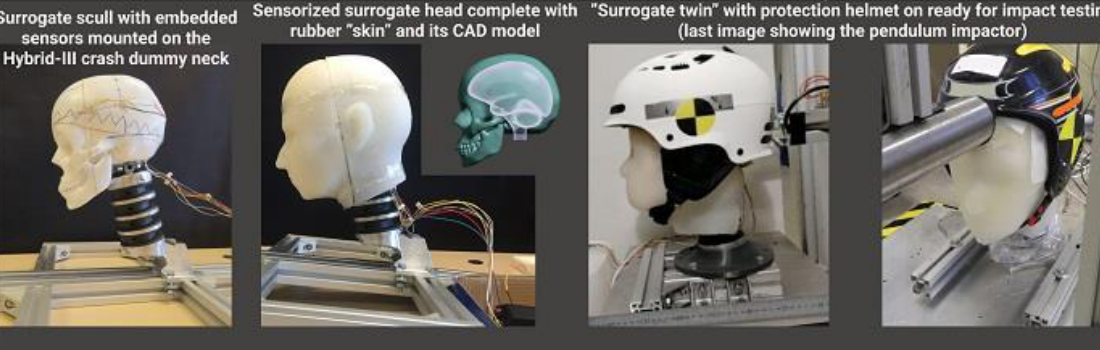
Figure 5. Example of body part surrogate for VRE. Photo courtesy of Prof. A. Koptyug, SportsTech Research Center, Mid Sweden University, Sweden.